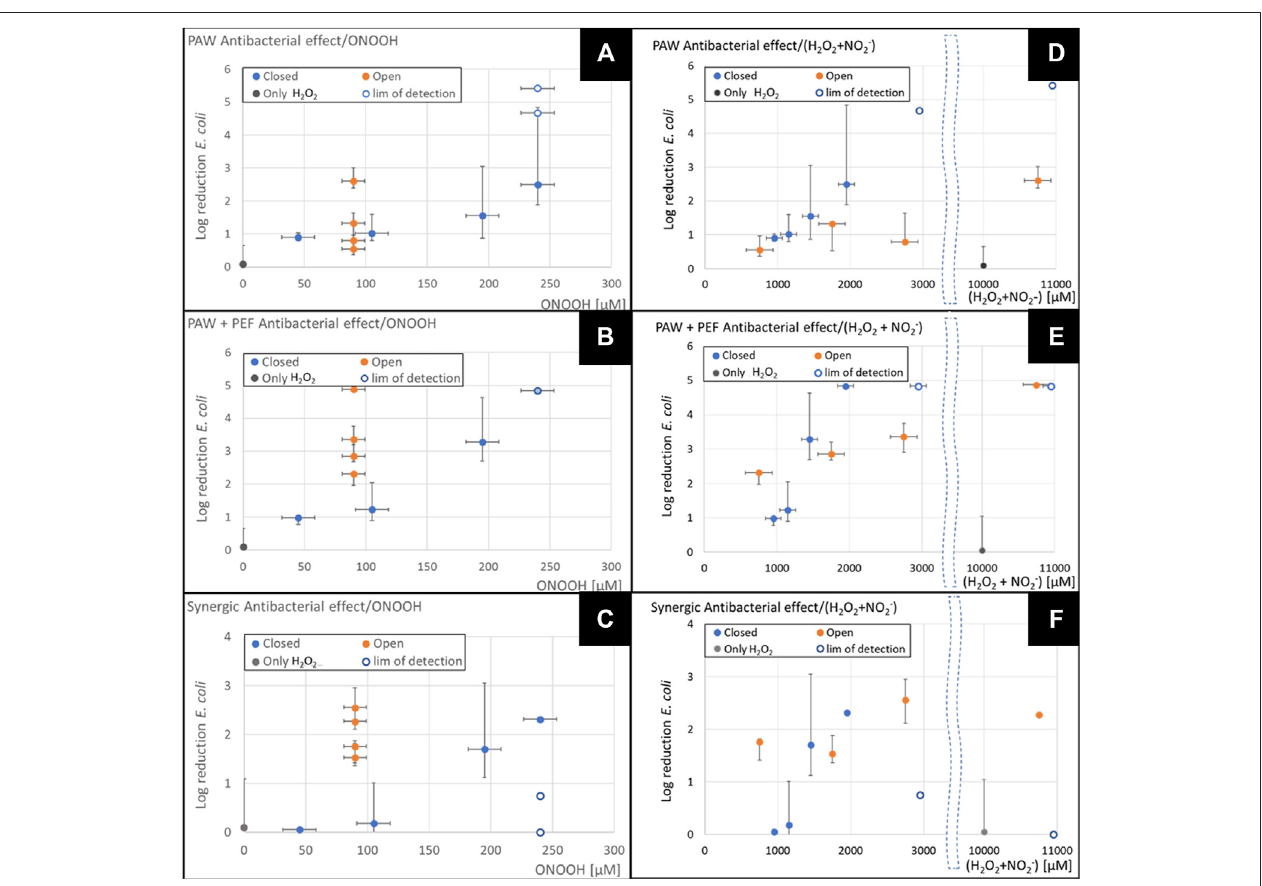
FIGURE 9 | Antibacterial effects expressed as log reduction as a function of the sum of NO − 2 and H 2 O 2 (A – C) and estimated ONOOH concentration (D – F) . (A,D) PAW antibacterial effect. (B,E) Total antibacterial effect of PAW with PEF. (C,F) Synergic antibacterial effect expressed as the difference between the total antibacterial effect and the PAW only antibacterial